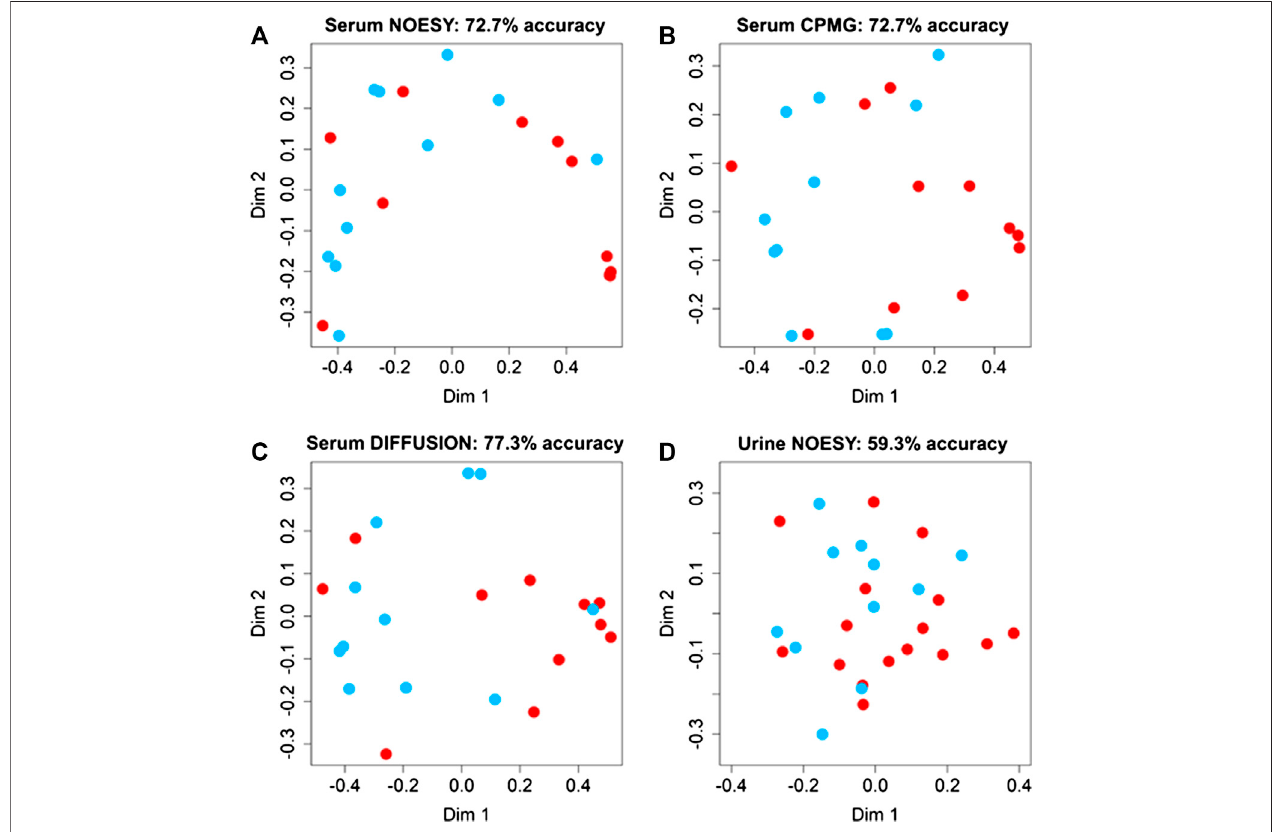
FIGURE 4 | Confusion matrices and score plots of the fi rst two principal components of the Random Forest models discriminating patients that experienced (red dots) and not experienced (blued dots) adverse effects to the administration of PDE5 inhibitors calculated on the NMR spectra acquired: (A) serum NOESY; (B) serum CPMG; (C) serum DIFFUSION; (D) urine